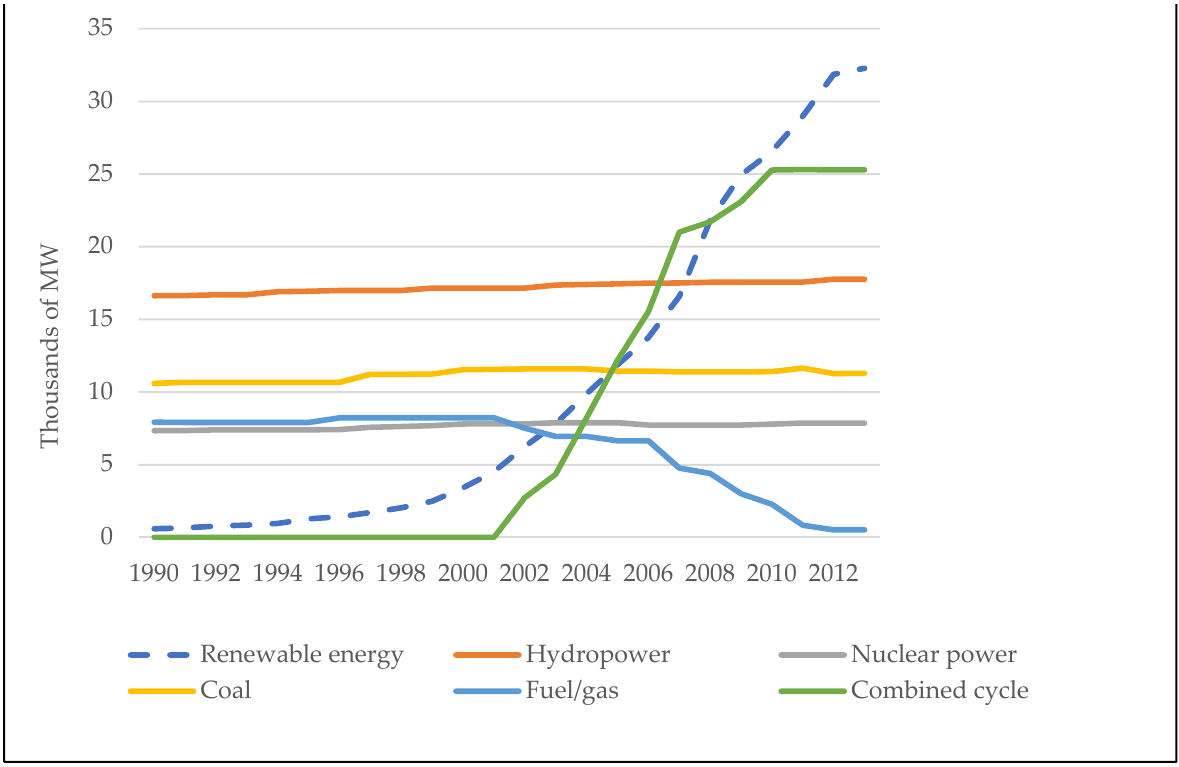
Figure 3. Installed power by source of energy (1990–2013). Source: REE data.